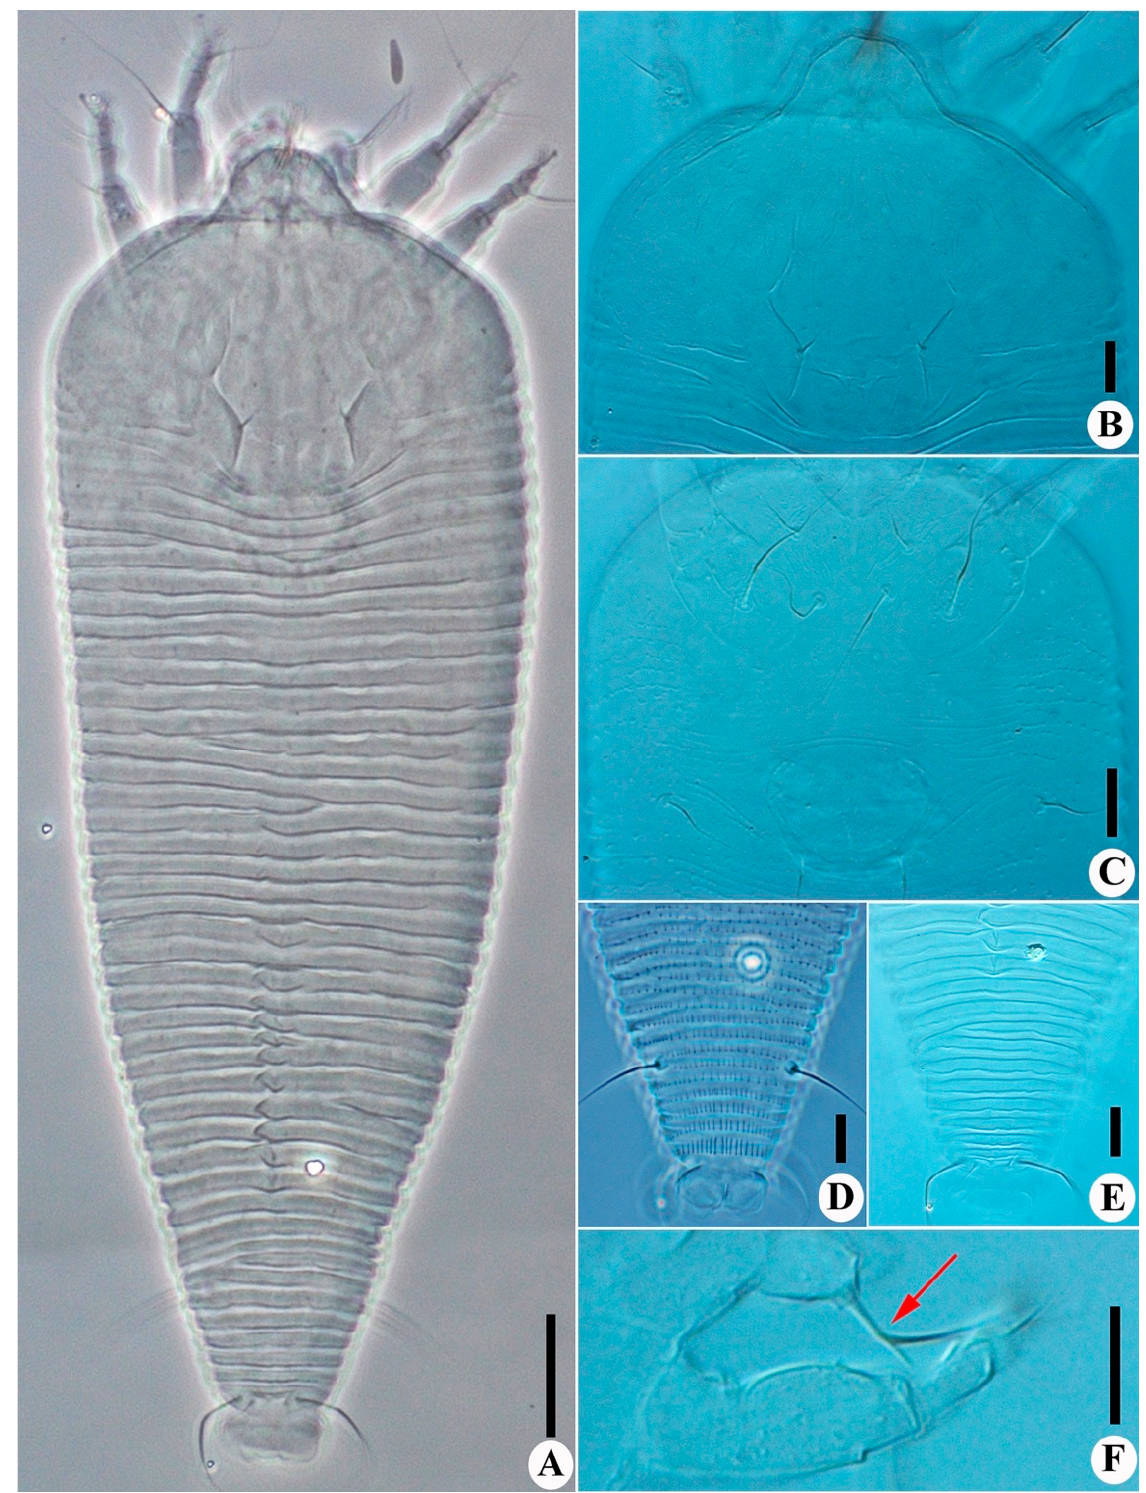
Figure 2. Leipothrix ventricosis sp. nov. ( A ) dorsal view; ( B ) prodorsal shield; ( C ) female coxigenital area; ( D ) ventral view of telosoma; ( E ) dorsal view of telosoma; ( F ) dorsal pedipalp genual setae d , arrow indicates the branched seta. Scale bar: 20 μ m for A; 10 μ m for B, C, D, E, F. Male: Not found.